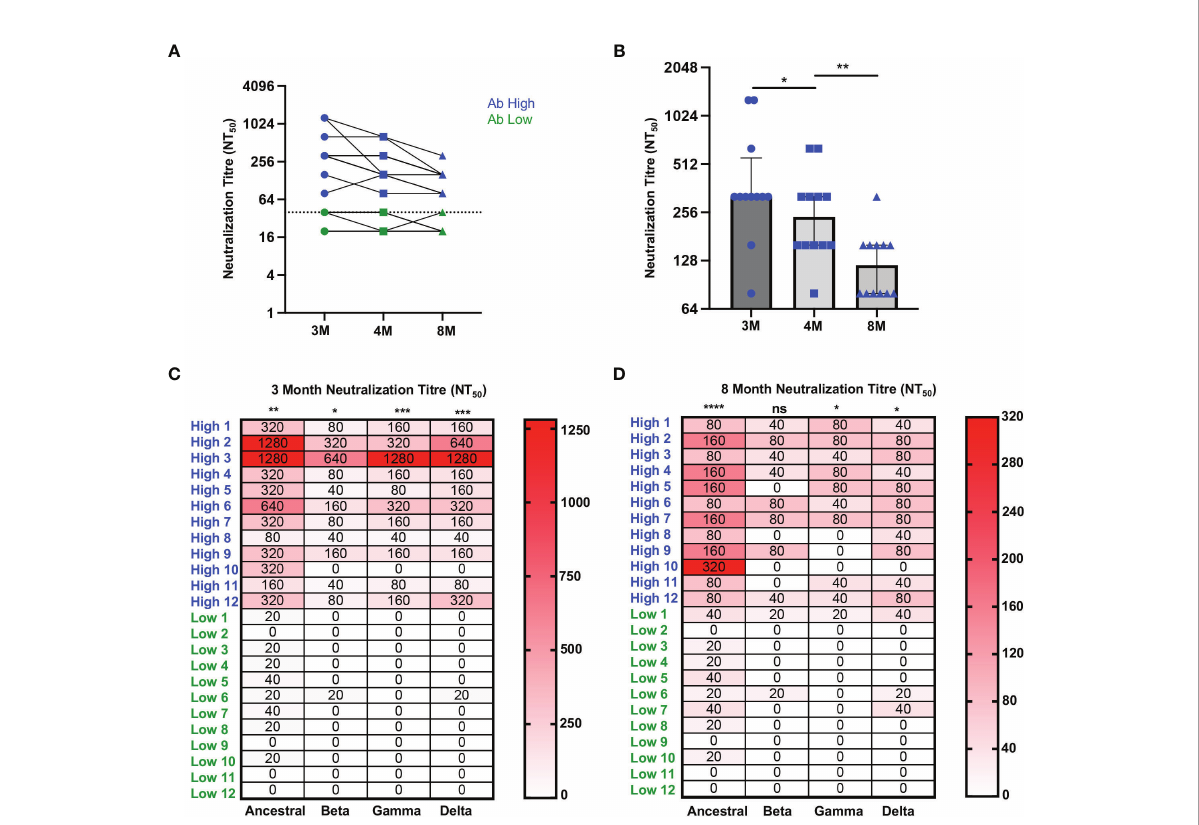
FIGURE 2 Higher neutralization breadth in Ab high group that decreases over time. (A) Representative dot plot showing difference in neutralisation of Ab high (blue) and Ab body low (groups) over time. (B) Reduction of neutralizing antibodies over time. 3M (3 months), 4M (4 months), 8M (8 months). (C) Increased neutralising breadth of Ab high group compared to antibody low. (D) Decreased neutralization tire in Ab high group at 8- months post-infection but remain higher than Ab low. Two-tailed p values <0.05 were considered signi fi cant (ns-not signi fi cant, *<0.05, **<0.01, ***<0.001, ****<0.0001). Wilcoxon T tests were used for paired groups and Mann-Whitney used for unpaired. Heatmap values shown as median neutralization